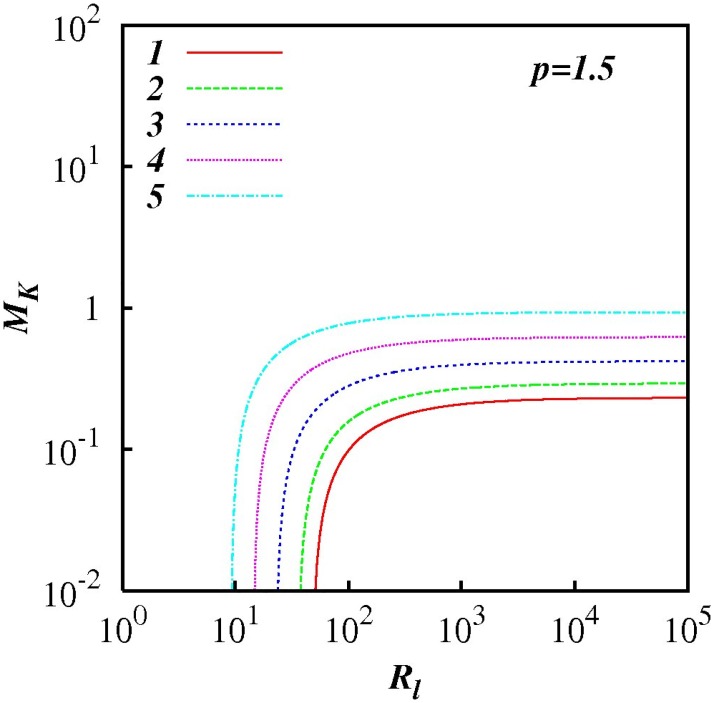
Similar to Fig 7, except for p = 1.5.